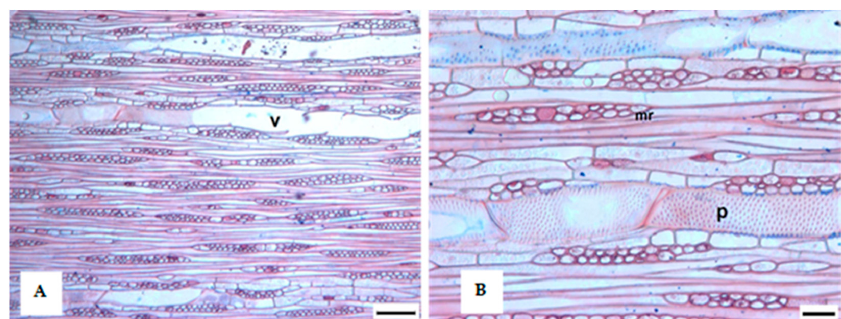
Figure 4. Tangential section from L. azorica (Seub.) Franco secondary xylem. ( A ) General view including xylem vessels (v) and multiseriate rays (scale bar 150 µ m). ( B ) A more detailed view showing a closer perspective of multiseriate rays (mr) and the presence of intervessel pits (p) (scale bar 50 µ m).